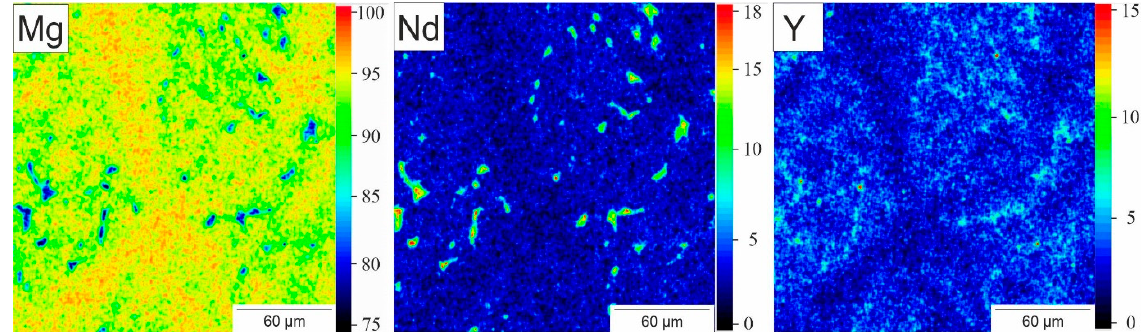
Figure 7. Element mapping of Mg, Nd and Y of the specimen in section in